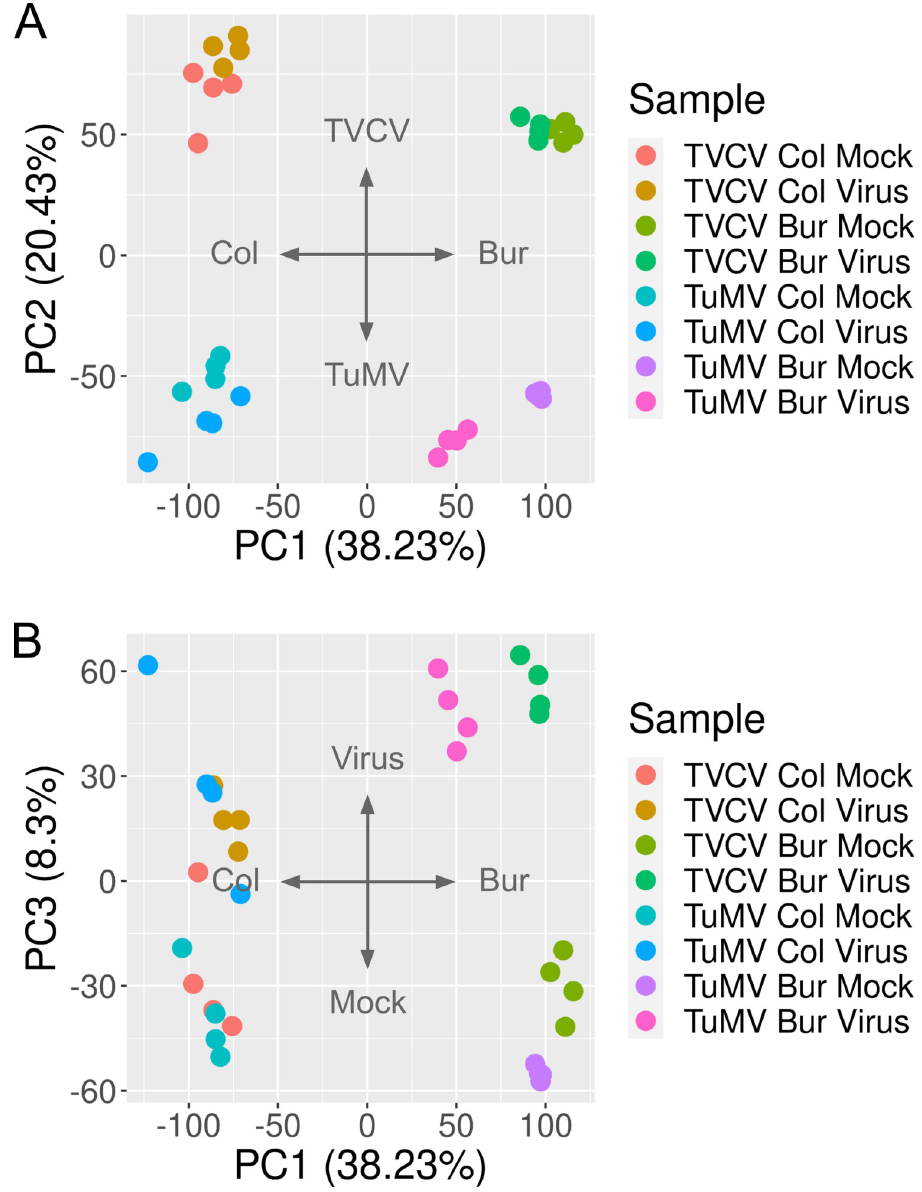
Fig 2. Principal component analysis of the RNA-seq data. PCA was performed using the prcomp R package. Normalized gene expressions (Transcript Per Million, TPM) were scaled and centered before the analysis. (A) The first component (PC1) separates the samples by ecotype and explains 36.85% of the total variances between the samples while the second component (PC2) separates the samples by virus series and explains further 23.35% of the variances. (B) The third component (PC3) separates samples that are either mock or virus-infected, which is responsible for a further 8.06% of the variances. The four biological replicates are marked with the same color for easier identification.